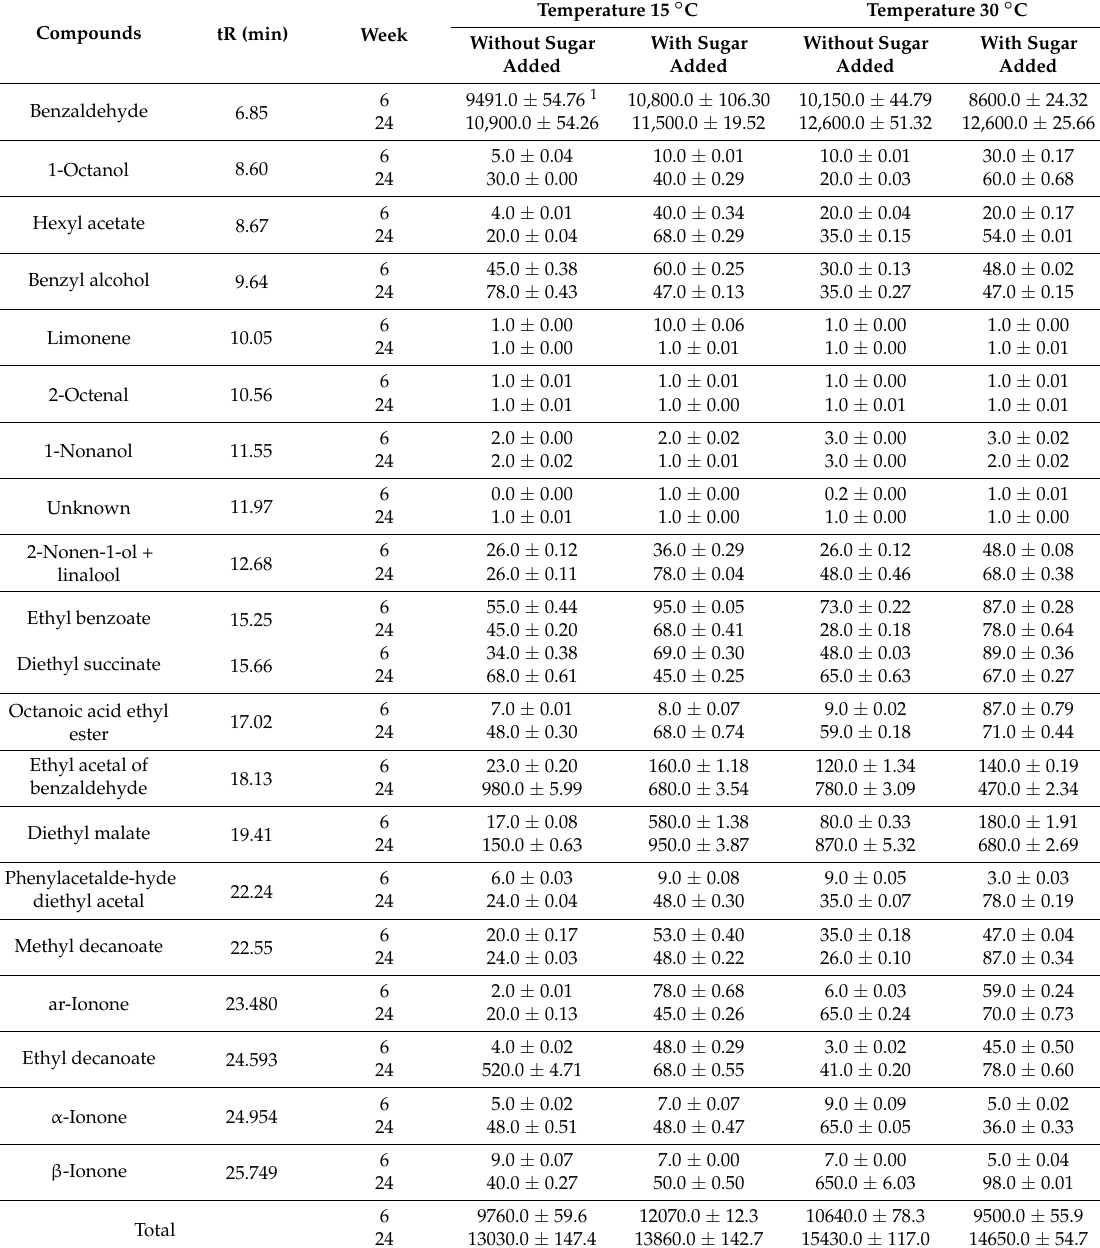
Table 6. Aroma compounds quantified in cherry liqueurs ( µ g/100